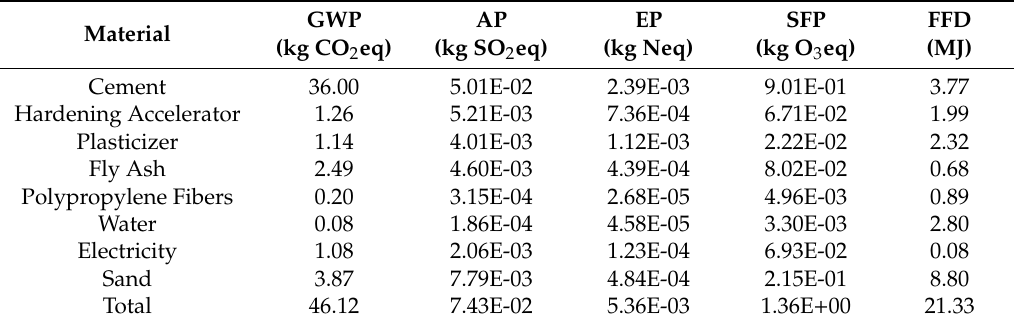
Table 6. Breakdown of material environmental impact contribution of